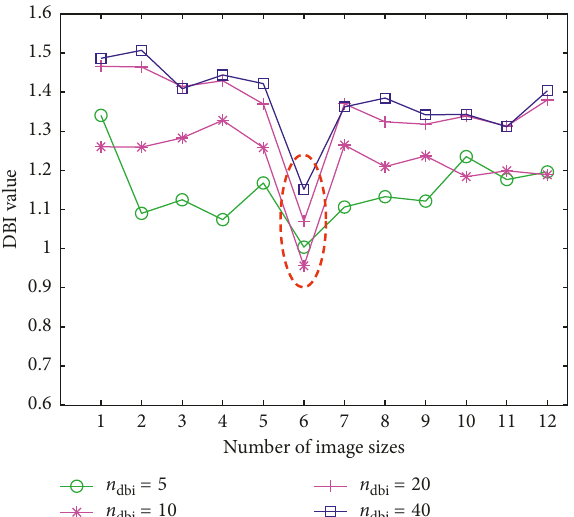
Figure 6: Experiment I: the DBI values for different image